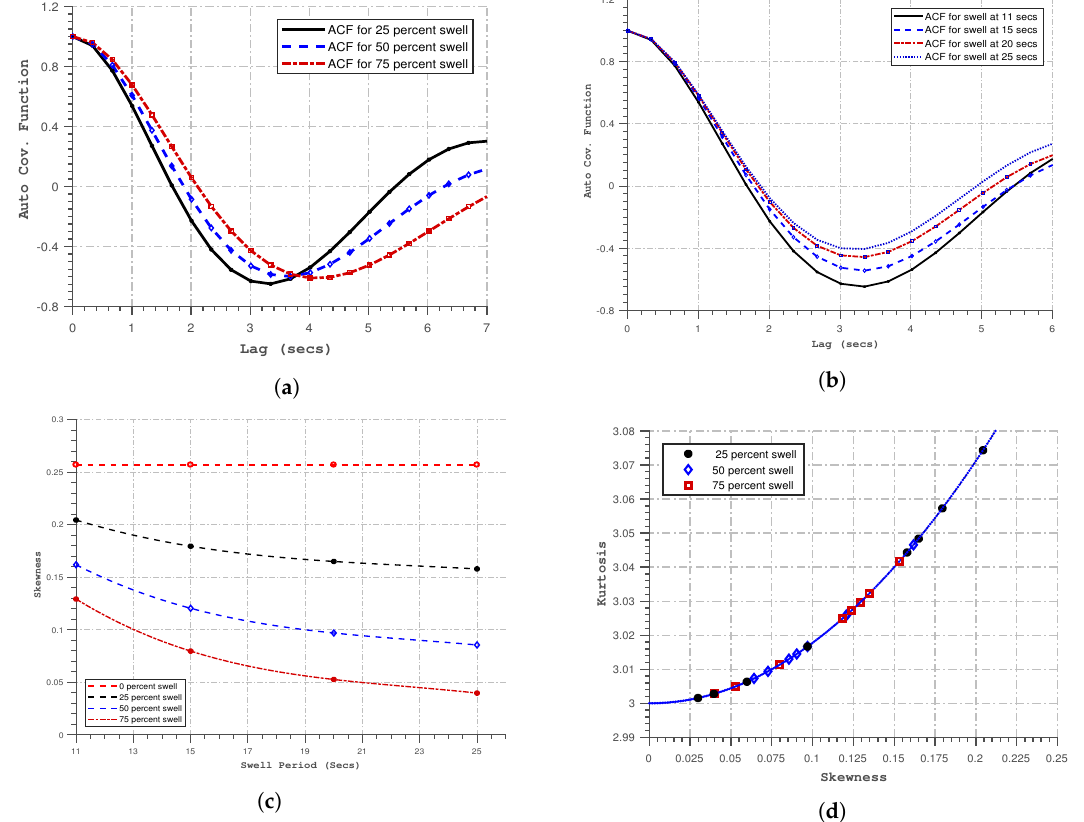
Figure 6. Time variance analysis of the effects swell periods and percentages in a bimodal sea with H m 0 = 4 m and T pW = 7 s . ( a ) Relationship between the Auto-covariance function ACF with increasing overall swell percentages in a bimodal sea; ( b ) Relationship between the ACF with increasing swell periods in a bimodal sea; ( c ) Variation of skewness with swell periods; ( d ) Variations of kurtosis against skewness for different swell